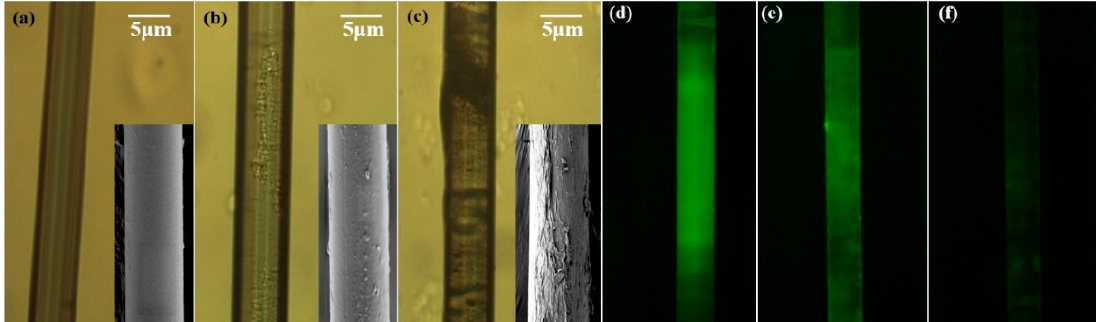
Figure 5. Microscope images and SEM images of ( a ) bare microfiber, ( b ) APTES-modified microfiber, and ( c ) GO-deposited microfiber; fluorescence images of ( d ) GO-coated microfiber, microfiber after reaction with ( e ) 0.2 mg/mL and ( f ) 1 mg/mL Hb solutions.